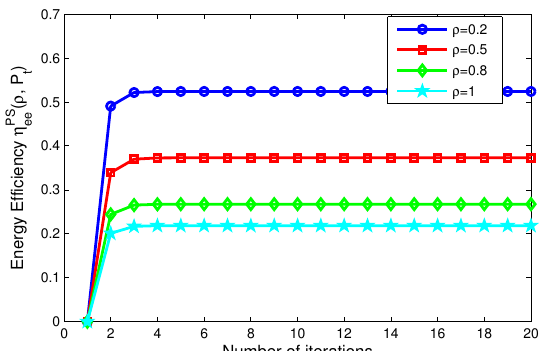
Figure 7. Energy efficiency versus number of iterations with different power splitting ratios for PS mode.